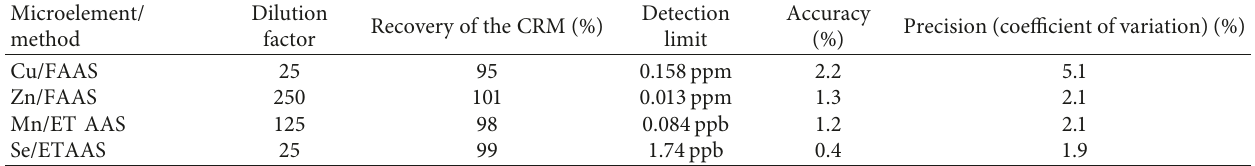
Table 2: Validation parameters of the methods used for the determination of microelements.